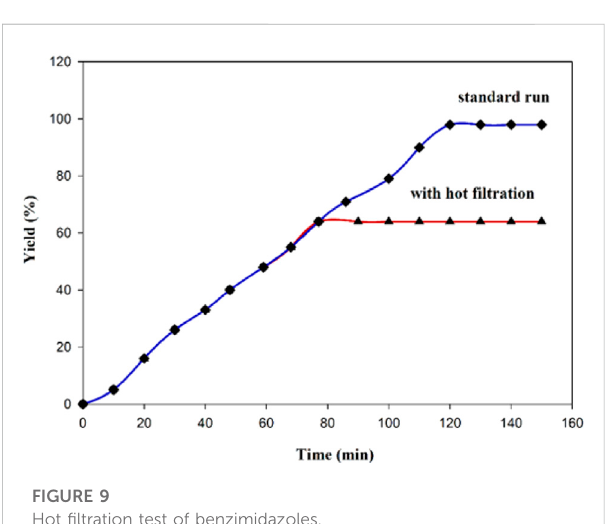
FIGURE 9 Hot fi ltration test of benzimidazoles.